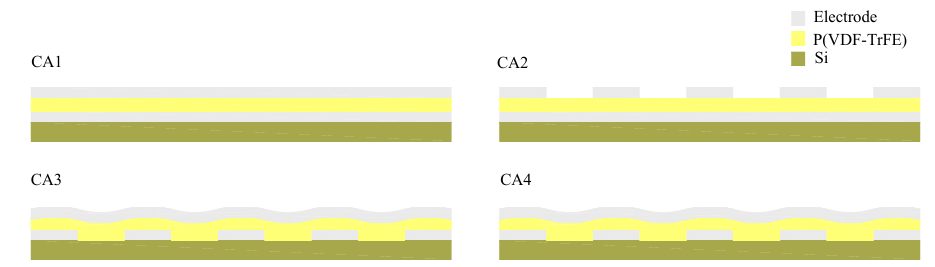
Figure 1. The scheme depiction of capacitor with different electrode structures. (CA1) Flat-flat capacitor with flat top and bottom electrode structure. (CA2) Line-flat capacitor with line top and flat bottom electrode structure. (CA3) Flat-line capacitor with flat top and line bottom electrode structure. (CA4) Line-line capacitor with line top and bottom electrodes perpendicular to each other.